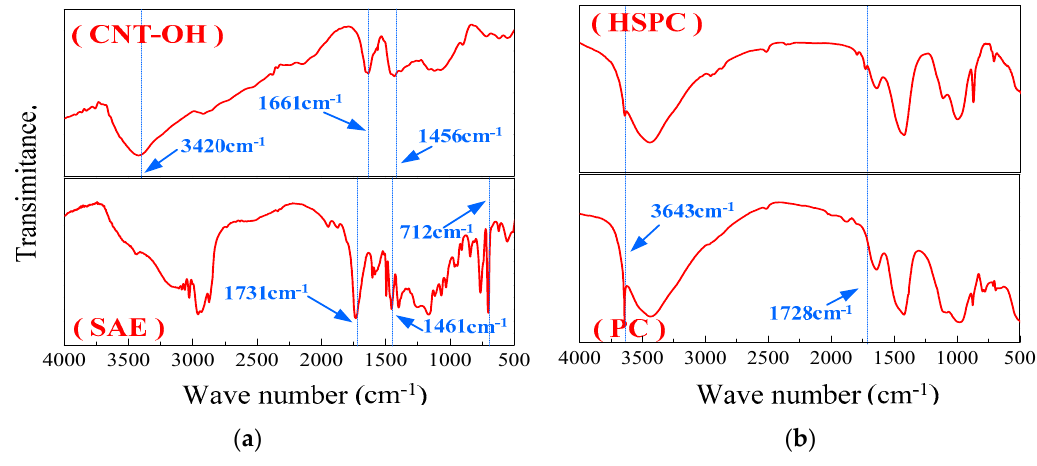
Figure 9. FTIR spectra of CNT–OH, SAE ( a ) and HSPC, PC ( b ) at 28 days.